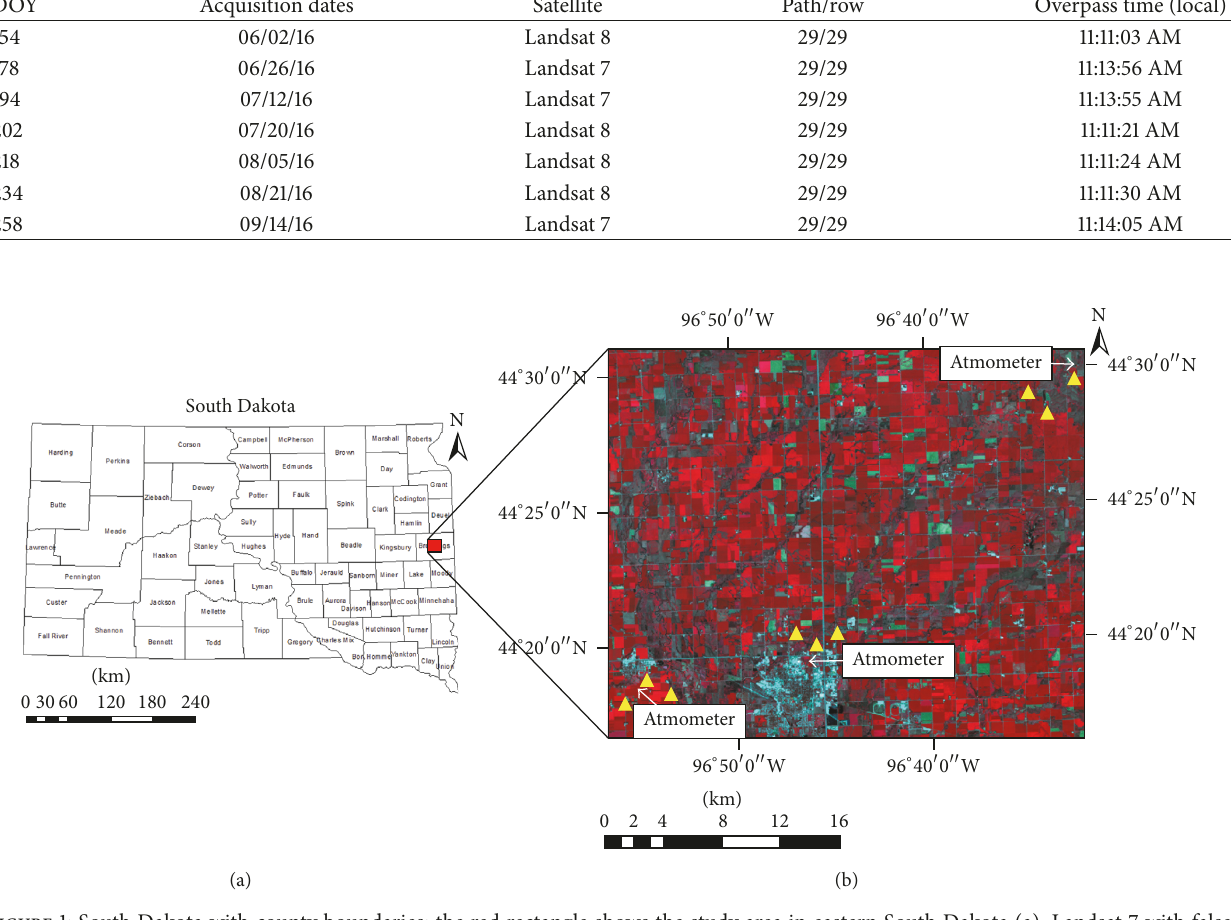
Figure 1: South Dakota with county boundaries: the red rectangle shows the study area in eastern South Dakota (a). Landsat 7 with false color composite (bands 4, 3, and 2) indicates the atmometer locations and the nine yellow triangles show corn field sites (b).